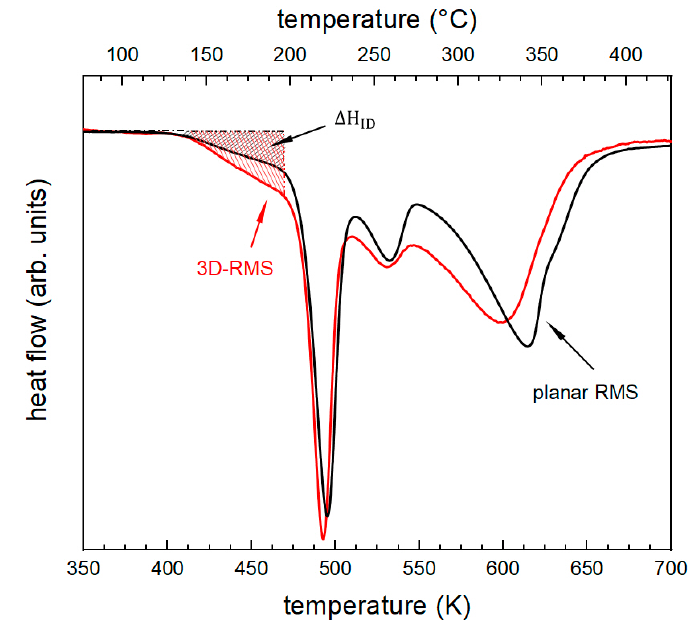
Figure 8. Comparison of the DSC heating scans obtained by heating with a constant rate of 0.333 K s − 1 . The scans of the planar RMS and 3D-RMS are associated with the black and red curve, respectively. To compare both morphologies, the heat flow curve for the 3D-RMS was normalized on the peak depth of the first sharp exothermic event of the DSC scan with planar RMS.